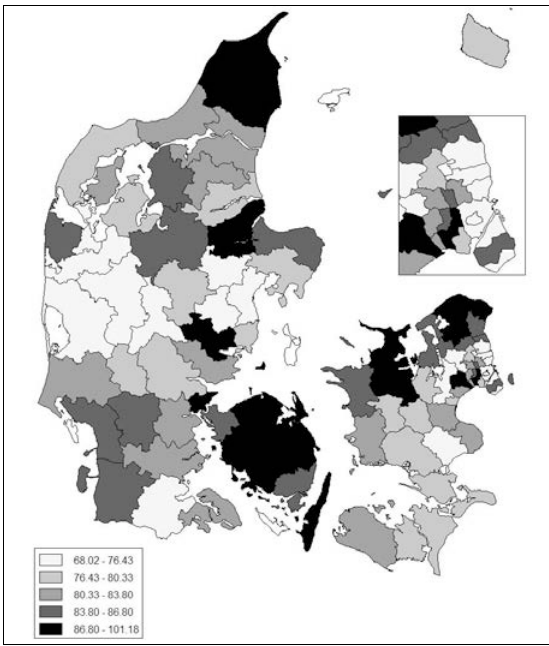
Figure 3. Number of medicated for asthma / COL per 1000